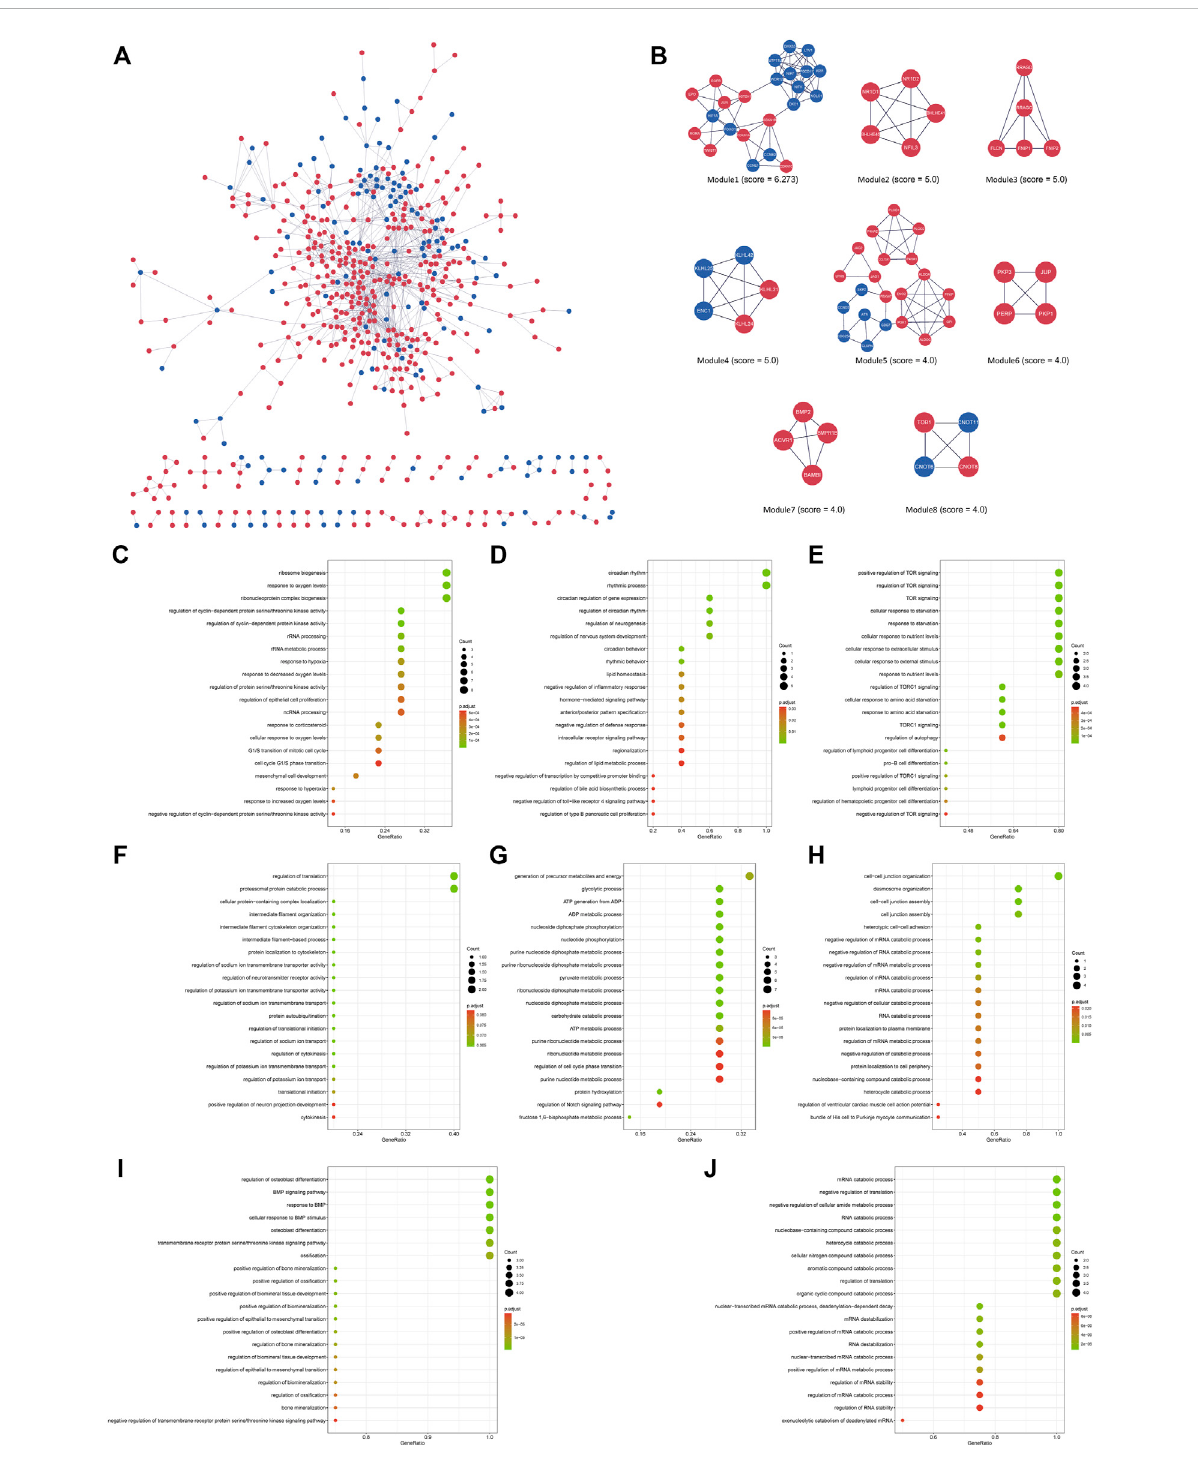
FIGURE 5 (A) The interaction network between proteins coded by DEGs comprised 563 nodes and 1,050 edges in the 8 h model. The red and blue circle nodes represent upregulated and downregulated DEGs, respectively. (B) Eight cluster modules extracted by MCODE. (C) GO enrichment analysis of Module 1. (D) GO enrichment analysis of Module 2. (E) GO enrichment analysis of Module 3. (F) GO enrichment analysis of Module 4. (G) GO enrichment analysis of Module 5. (H) GO enrichment analysis of Module 6. (I) GO enrichment analysis of Module 7. (J) GO enrichment analysis of Module 8.